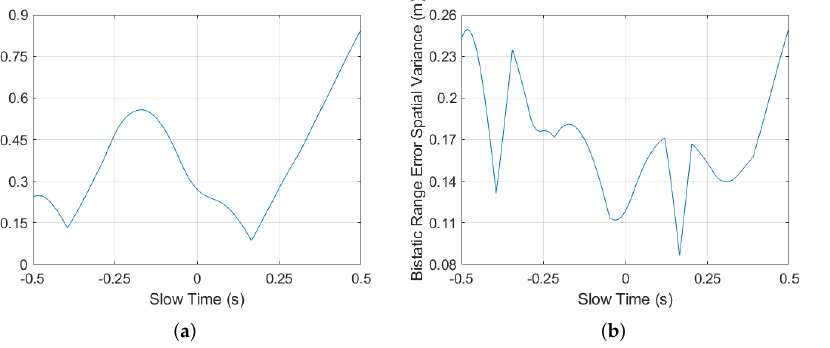
Figure 6. Properties of simulated bistatic SAR motion error: ( a ) cross-cell properties; ( b ) spatial variance